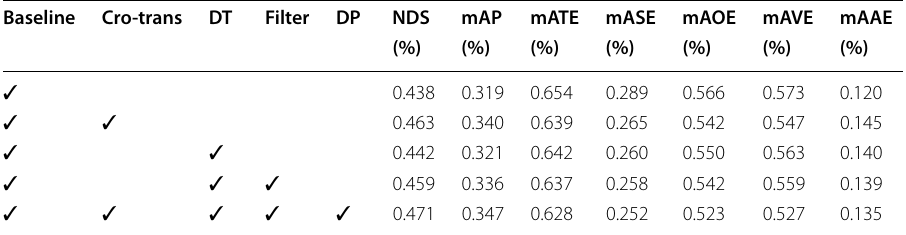
Cro-trans denotes cross-transformer DT Depth threshold, DP